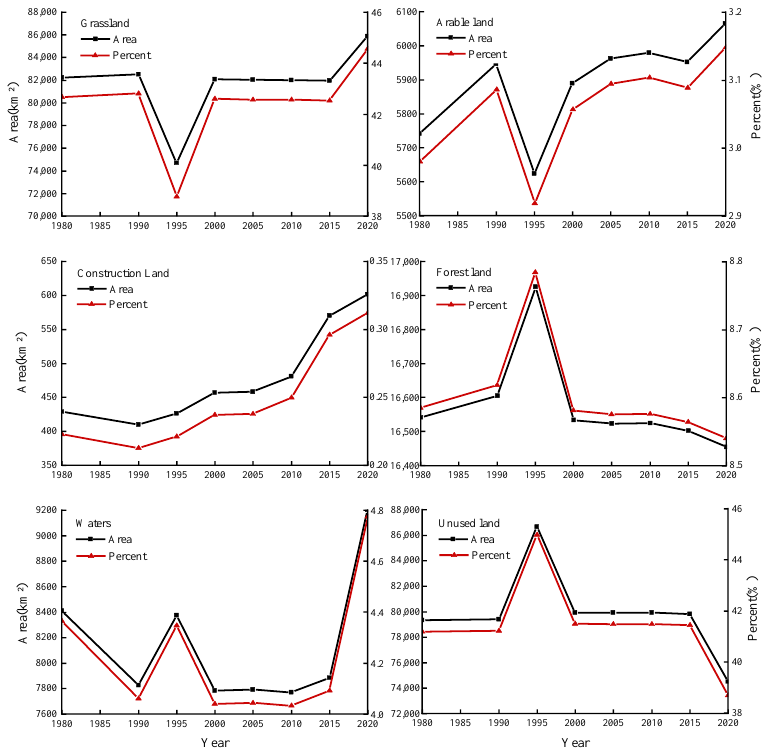
Figure 4. Characteristics of land use structure in the Qilian Mountains. Table 2. Structural characteristics of land use in the Qilian Mountains from 1980 to 2020.